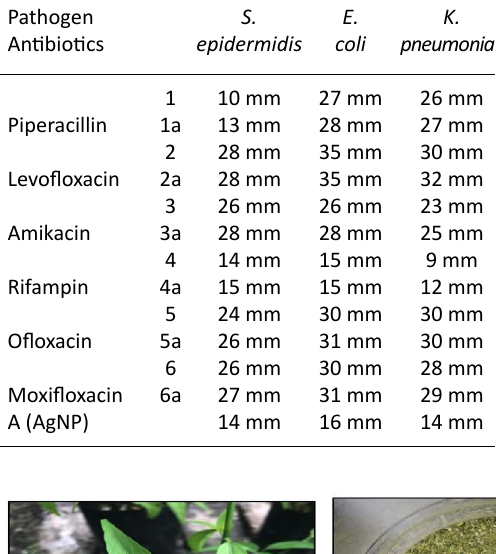
Table 1. Zone of inhibition for combination of antibiotic with and without AgNPs against selected pathogen